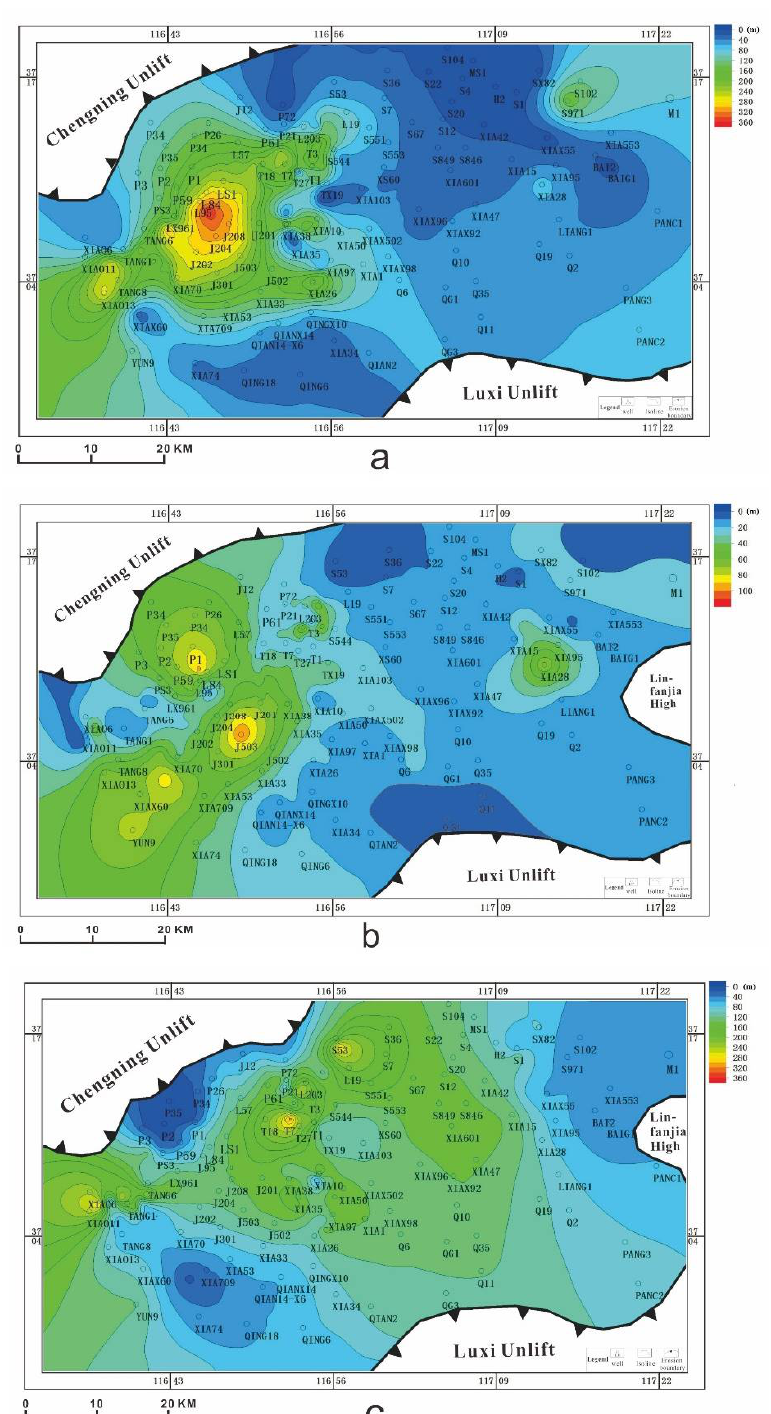
Figure 9. Isopach map of sandstone in the Huimin depression. Isopach maps of ( a ) sandstone thickness in Ed, ( b ) sandstone thickness in Es 1 , and ( c ) sandstone thickness in Es 2 .